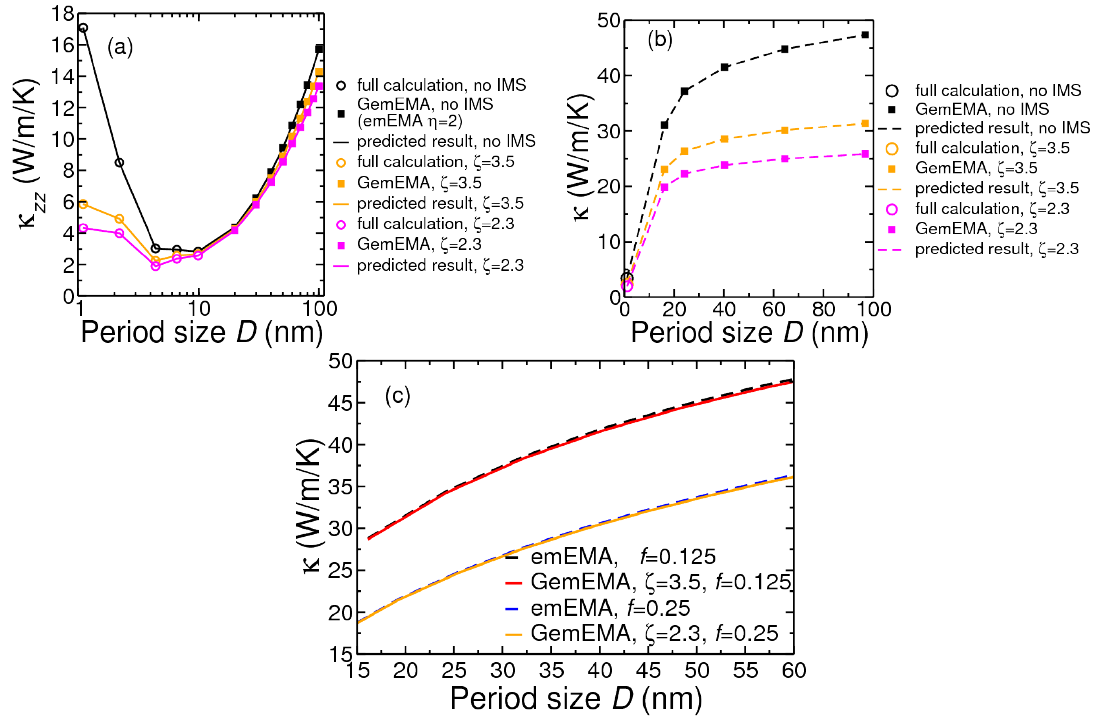
Figure 7. Period size dependence of room-temperature κ zz for sample size 500 nm: ( a ) for Si( D /2)/Ge( D /2) PSL, with various amounts of interface mass smudging (IMS); ( b ) Ge/Si NDSL, with Ge insert fraction of f = 0.125; ( c ) MoS 2 /WS 2 NDSL, with WS 2 insert fraction of f = 0.125. Boundary and interface scattering rates are calculated with the choice of the inhomogeneity factor η = 2. In panel ( b ) the shape of the smallest Ge insert was